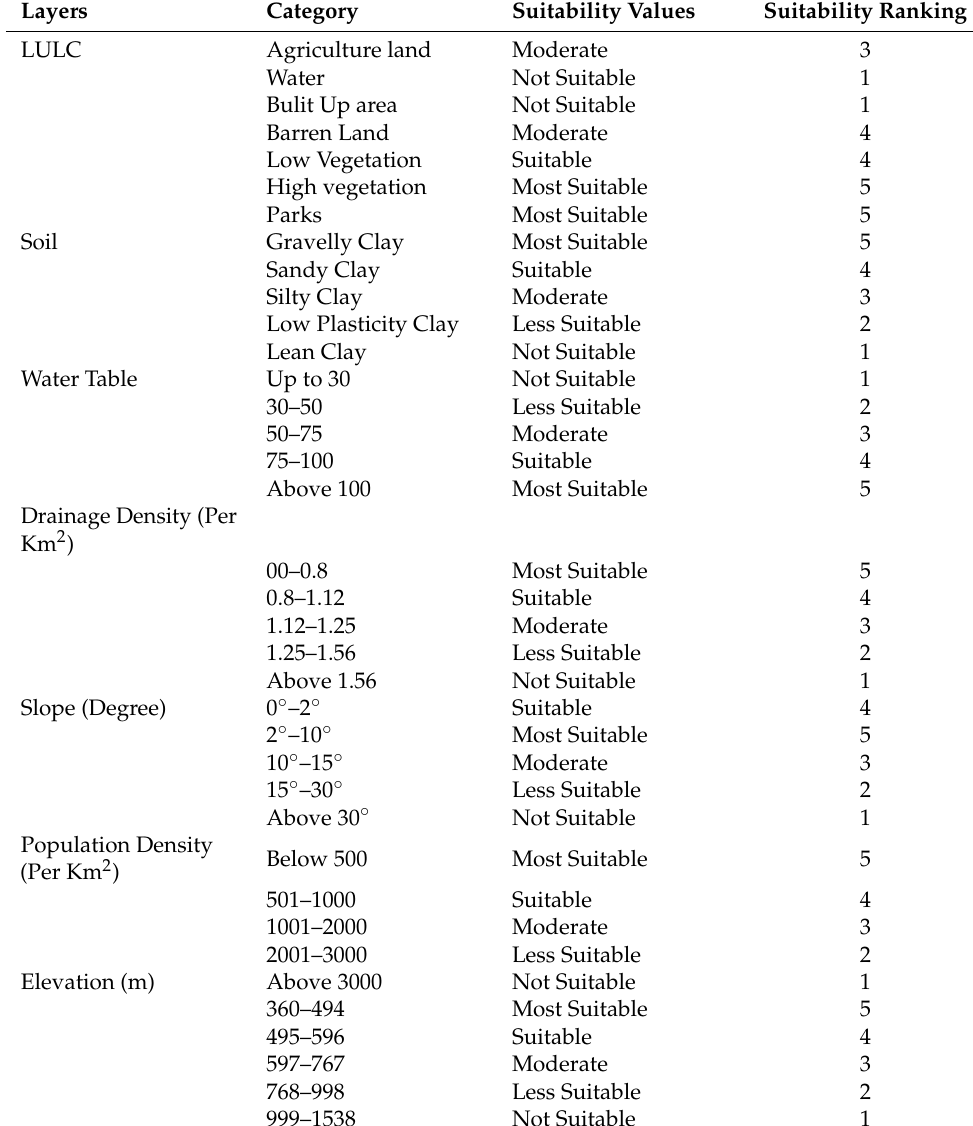
Table 6. Suitability ranks for Sub-criteria of selected